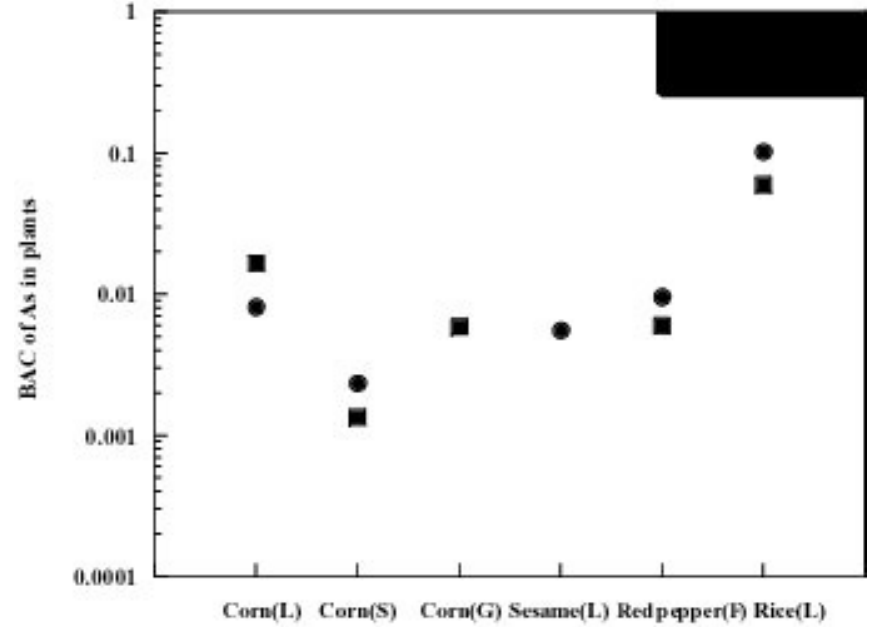
FIGURE 7. The variation of BAC in crop plants from the study areas (L: leaves, S: stalks, G: grains, and F: fruits).